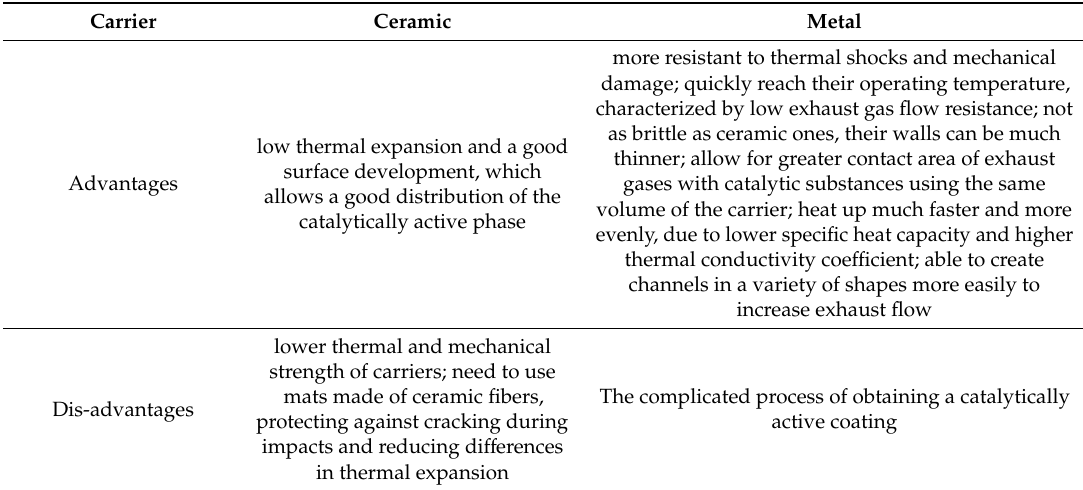
Figure 1. Catalytic carrier structure: ( a ) Ceramic; ( b ) Metallic; ( c ) Grinded catalytic converter (size lower than 0.063 mm). Table 1. Advantages and disadvantages of ceramic and metal carriers [17,19,21].